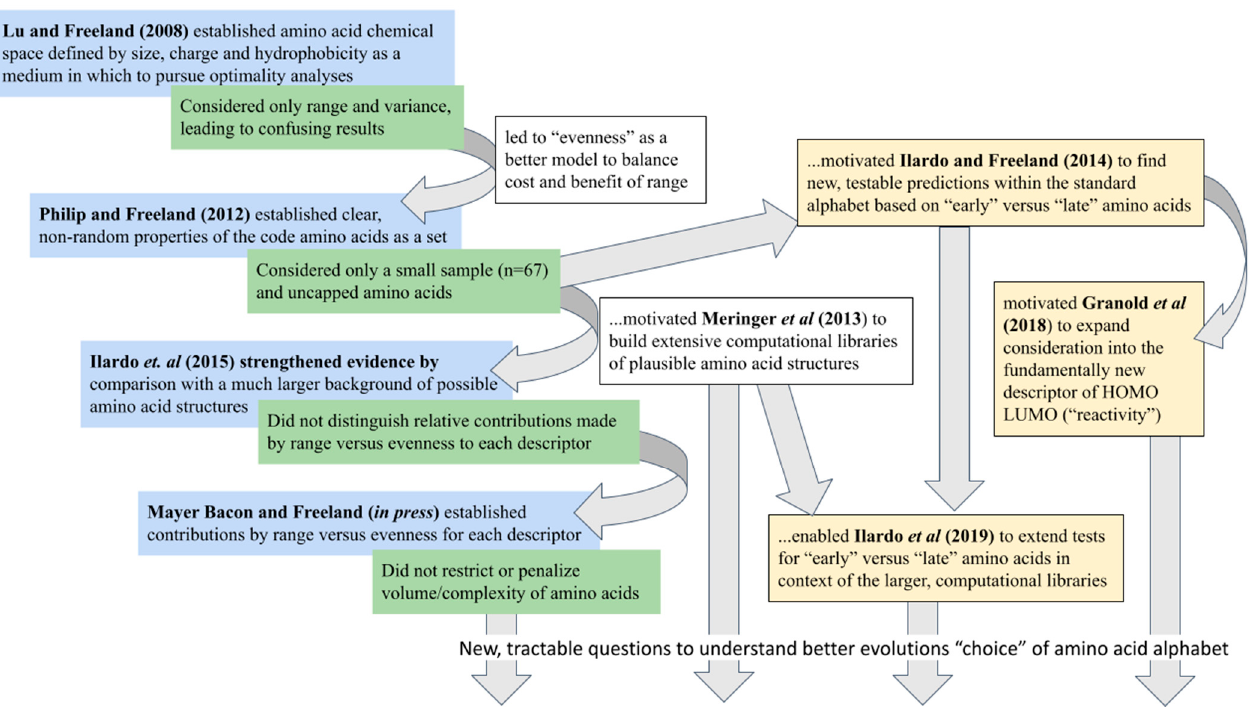
Figure 5. The series of publications reporting unusual features of physicochemistry for the standard amino acid alphabet may be viewed usefully as a series of flawed models attempting to answer the question “What exactly seems to have been optimized?” Following the optimality approach of evolutionary biology [46], the model grows more complex at each step, but only in specific, targeted attempts to address these flaws as they come to light. Each step reveals weaknesses in the assumptions thus far, stimulating subsequent steps in a process that refines the model by introducing statistical complexity only as